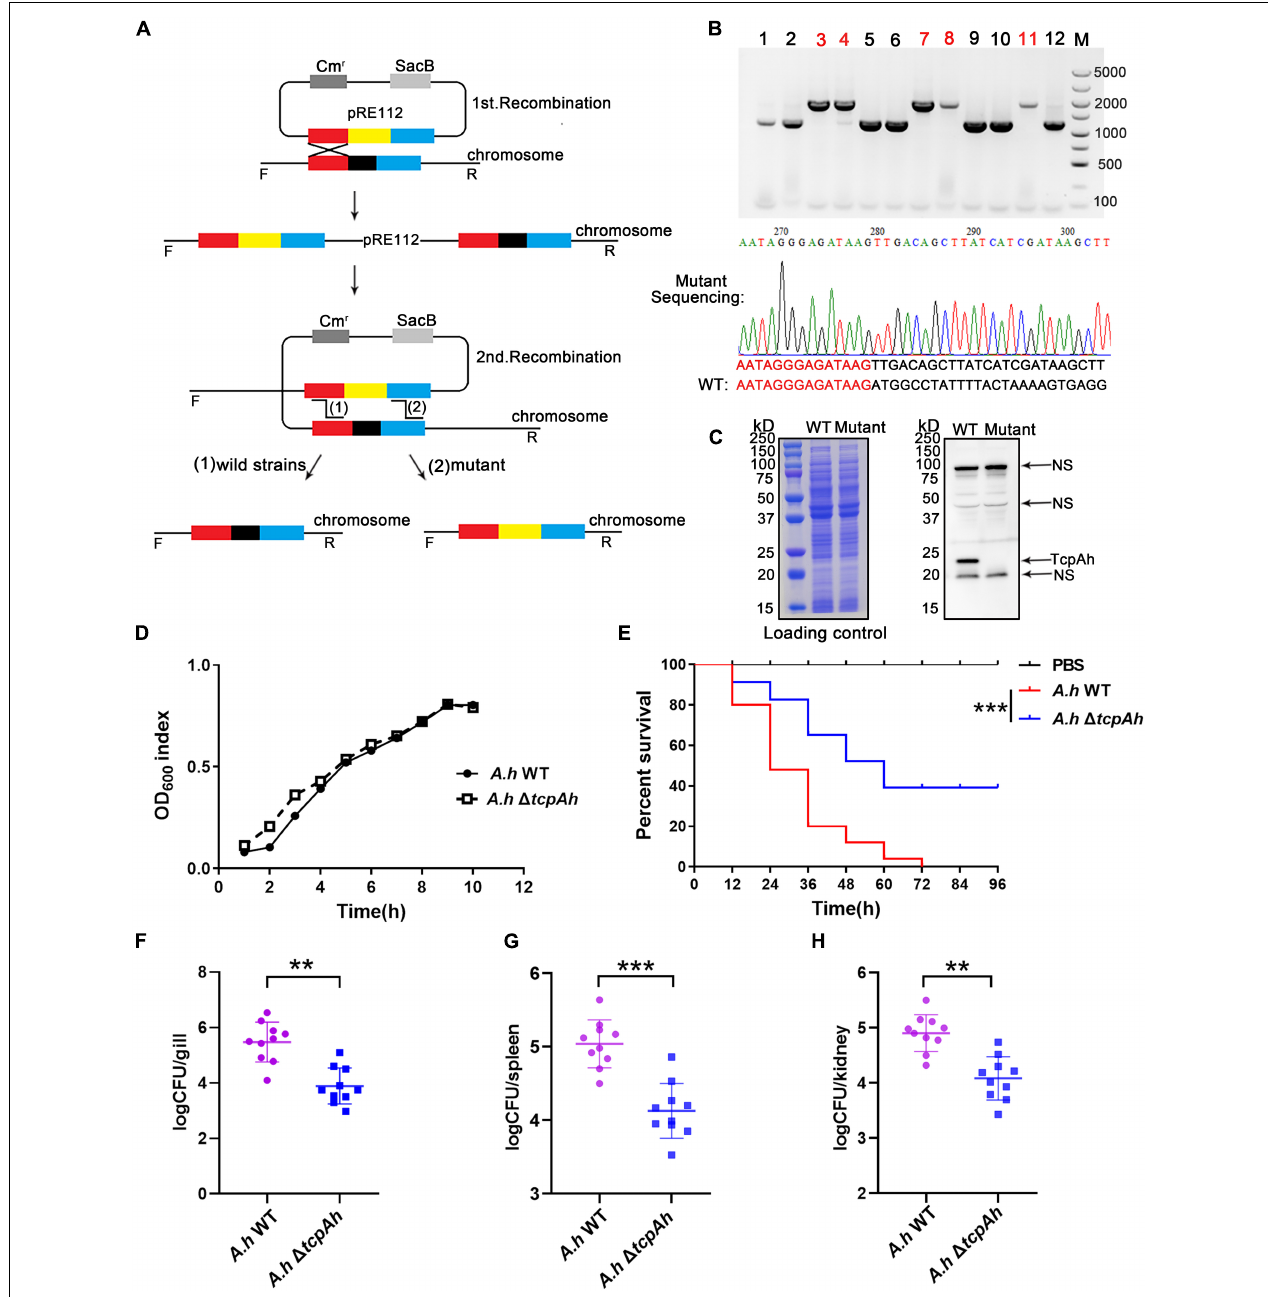
FIGURE 2 | Examination of the requirement of TcpAh for A. hydrophila infection. (A) Strategy for the deletion of the tcpAh gene in A . hydrophila JBN2301 strain by homologous recombination. The black block indicates the tcpAh gene; red and blue blocks indicate the left and right homologous sequences of the tcpAh gene, respectively; and the yellow block indicates the Tc r gene. (B) PCR and sequencing identification of the mutant strain with tcpAh gene deletion ( (cid:49) tcpAh ). The lanes with red number indicate the mutant strain; partial sequencing result is showed. (C) Western blot analysis of TcpAh protein in wild-type and mutant A . hydrophila JBN2301 strains in liquid cultures and NS means non-specific band. The total proteins of wild-type and (cid:49) tcpAh A . hydrophila JBN2301 strains were separated by SDS-PAGE and stained with Coomassie brilliant blue R250 as a loading control. The TcpAh protein was detected by using a polyclonal rabbit anti-TcpAh antibody with an expected molecular weight of 22 kDa. (D) Growth curve of wild-type and (cid:49) tcpAh A . hydrophila JBN2301 strains. (E) Zebrafish survival curve. Zebrafish were infected with wild-type A . hydrophila JBN2301 and (cid:49) tcpAh mutant. Statistical differences between wild-type versus (cid:49) tcpAh A . hydrophila infected groups were analyzed by log-rank test. n = 25. *** p < 0.001. Group of fish injected with mock PBS was used as a negative control. (F–H) Examination of bacterial load in the (F) gill, (G) spleen, and (H) kidney tissues of zebrafish infected with wild-type and (cid:49) tcpAh mutant A . hydrophila JBN2301 strains. Non-parametric